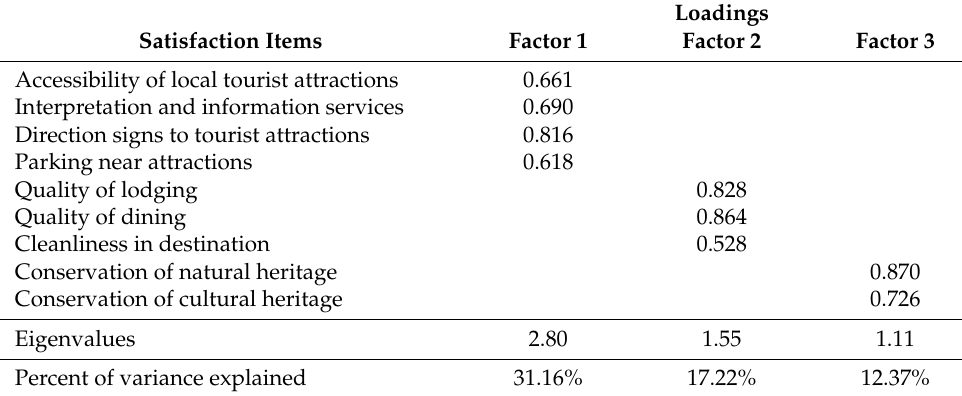
Table 4. The results of Exploratory Factor